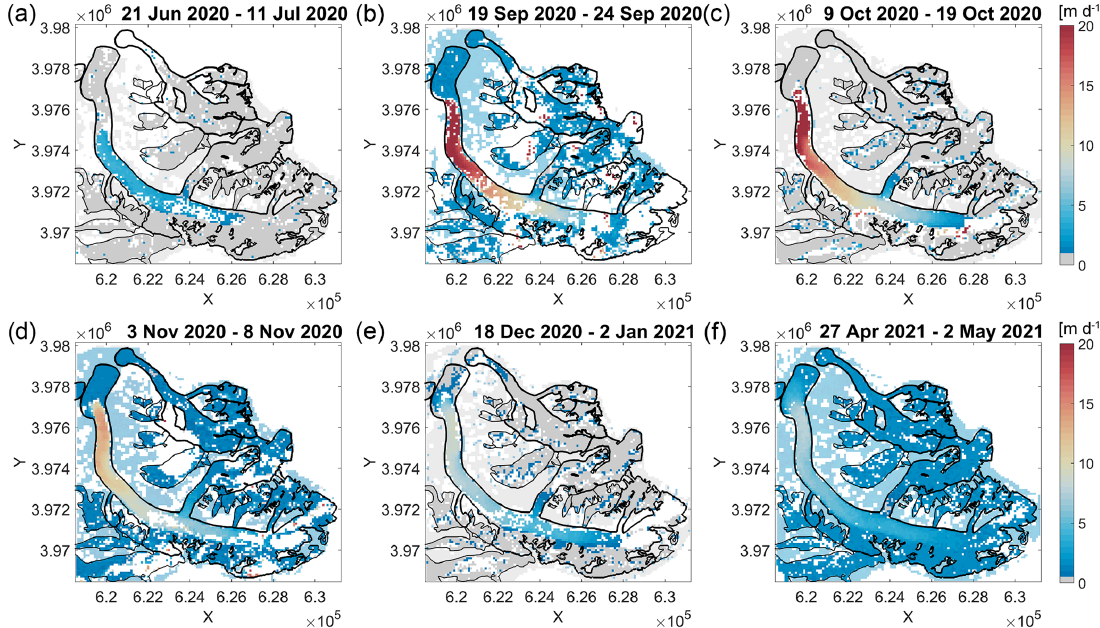
Figure 8. Temporal evolution of 2D flow velocities for South Chongtar Glacier during its surge as derived from Sentinel-2. The dates of the respective Sentinel-2 pairs are given at the top of each panel. Grey values refer to velocities smaller than 1 standard deviation (see Table S2), i.e. < 1md − 1 for panels (a) to (c) and < 0.5md − 1 for (d) to (f) .